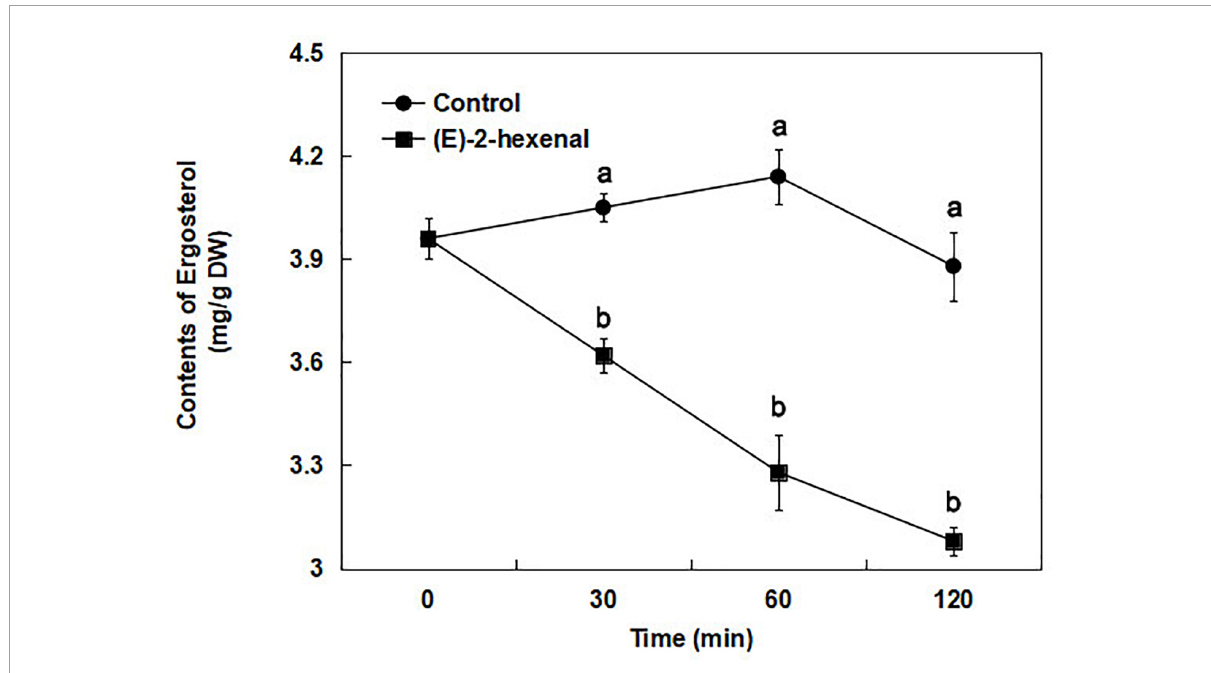
FIGURE8 Total ergosterol contents in B. cinerea control ( • ) and 1 × MFC ( E )-2-hexenal ( (cid:4) ) treated cells, and values are the mean + SD of three measurements. Symbols with different letters at each time point indicate significant differences according to Duncan’s multiple range test ( p <